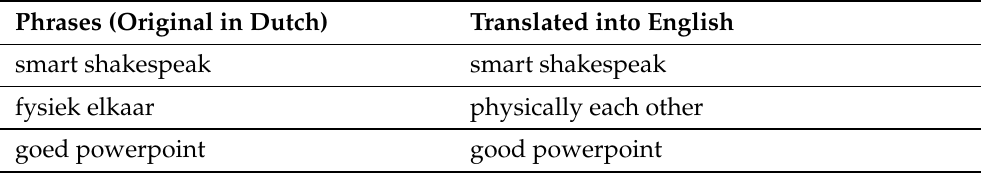
Figure 9. Topic clusters as word clouds in the red phase. Table 2. Bigrams of the TEL LA advisor with high tf-idf ranking (i.e., bigrams rarely used).